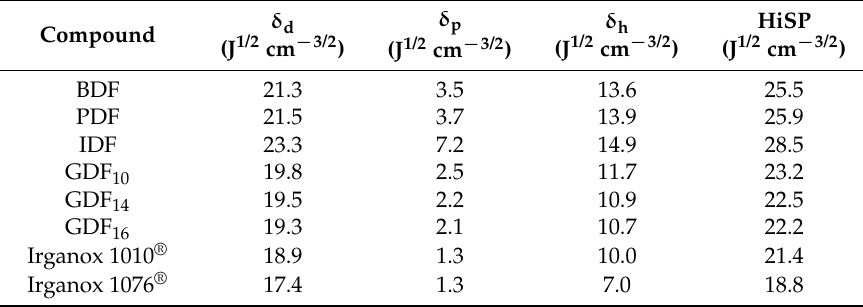
Table 1. Hildebrand solubility parameters (HiSP) of phenolic antioxidants.